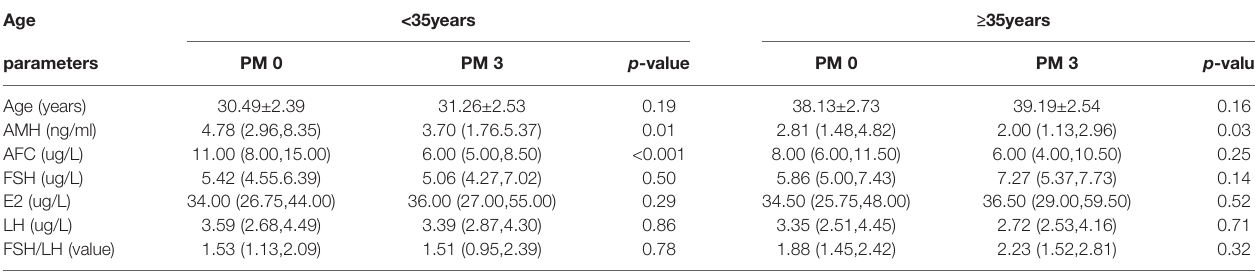
TABLE 3 | Comparisons of parameters of OR between the PM0 and PM3 groups with age strati fi cation.